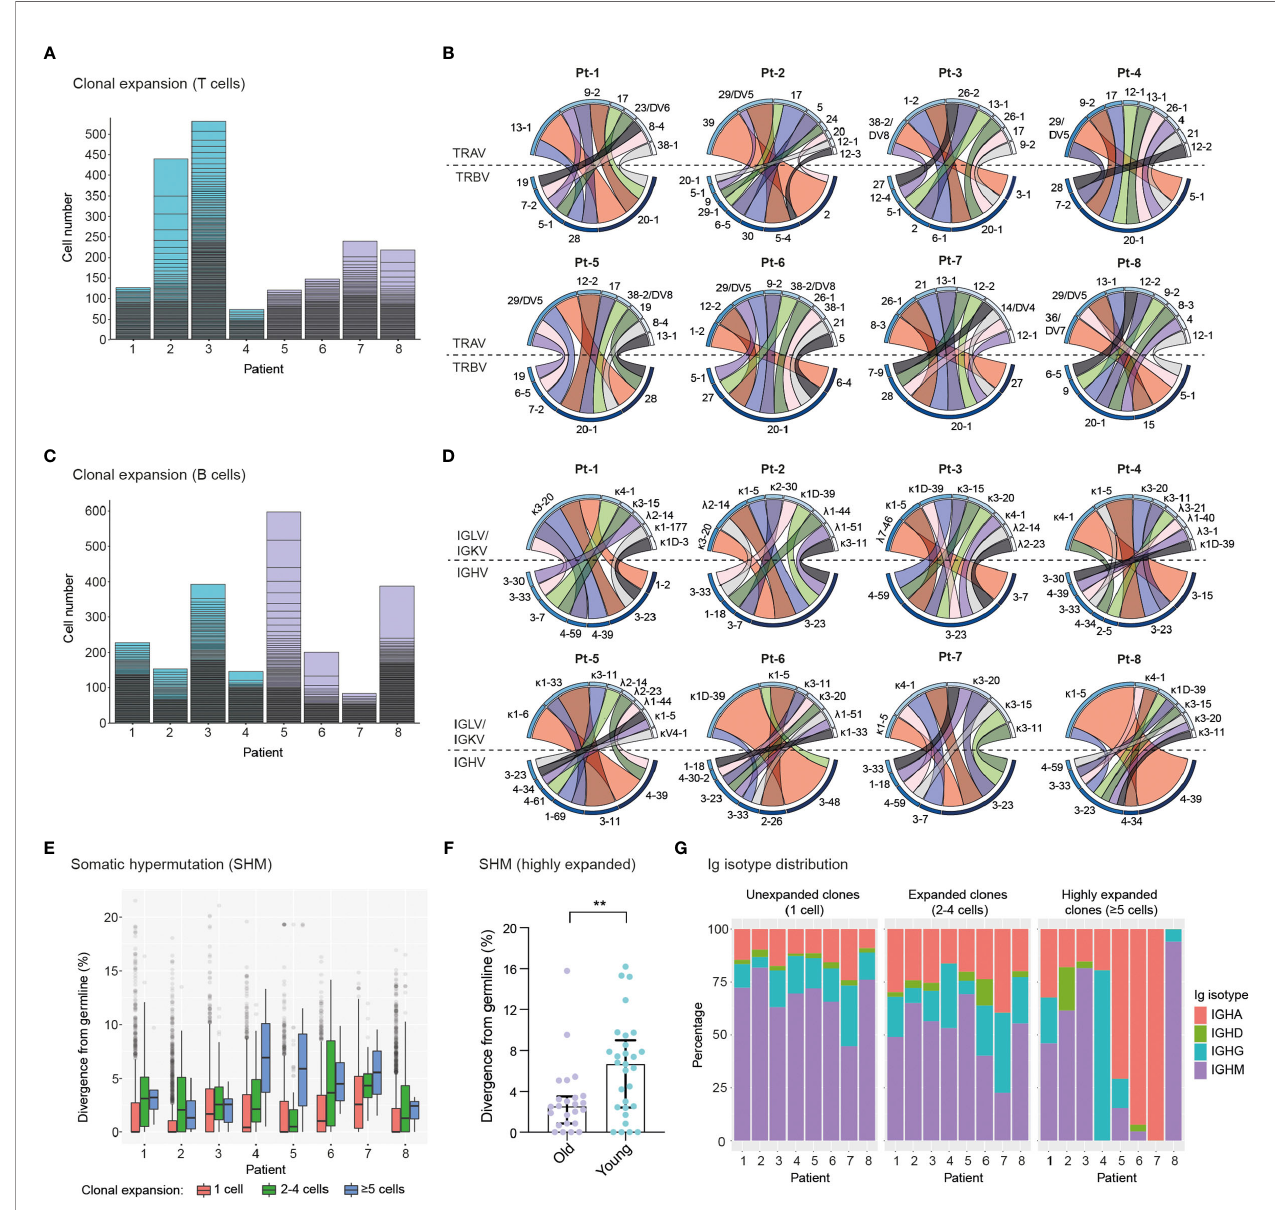
FIGURE 3 | Single-cell pro fi ling of immune repertoires highlights differential levels of inter-patient T cell and B cell clonal expansion. (A, B) , Analysis of T cell clonal expansion in convalescent COVID-19 patients. (A) Bar graphs show T cell clonal expansion, as determined by the number of cells identi fi ed per TCR clonotype. Each box represents the size of individual TCR clonotypes. TCR clonotypes present in more than one cell are shown. (B) Circos plots display V-gene usage in the top ten most expanded TCR clonotypes for each patient. The size and colour (dark to light) of outer bars re fl ect the relative abundance of T cells expressing speci fi c V-genes on a per class basis (top: TCR a chain, bottom: TCR b chain). (C – E) , Analysis of B cell clonal expansion in convalescent COVID-19 patients. (C) Bar graphs show B cell clonal expansion, as determined by the number of cells identi fi ed per BCR clonotype. Each box represents the size of individual BCR clonotypes. BCR clonotypes present in more than one cell are shown. (D) Circos plots display V-gene usage in the top ten most expanded BCR clonotypes for each patient. The size and colour (dark to light) of outer bars re fl ect the relative abundance of B cells expressing speci fi c V-genes on a per class basis (top: Ig light chain, bottom: Ig heavy chain). (E) Graph displays the levels of somatic hypermutation (SHM) in unexpanded (1 cell), expanded (2-4 cells) and highly expanded (5 cells) BCR clonotypes across patients. SHM levels are based on the percentage similarity between Ig heavy chain V-genes and their corresponding germlines. Data are displayed as median ± IQR. (F) , Graph displays SHM levels in highly expanded BCR clones ( ≥ 5 cells) of old (n = 24 clones) and young (n = 29 clones) patients. Asterisks indicate a signi fi cant difference in SHM levels between groups (p = 0.0085; unpaired t-test). Data are displayed as median ± IQR. (G) , Bar graphs show the Ig isotype distribution in unexpanded (1 cell), expanded (2-4 cells) and highly expanded ( ≥ 5 cells) BCR clonotypes across